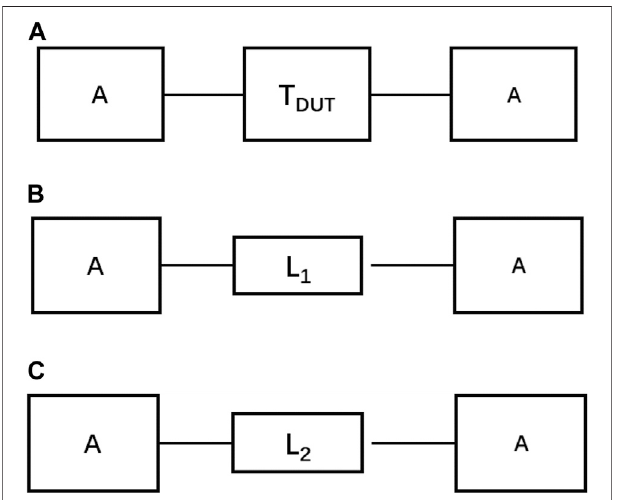
FIGURE 5 | Schematic diagrams of numerical TL de-embedding procedure and the two standards in TRL. (A) Two-port equivalent network under the numerical TL calibration. (B) Through standard. (C) Line standard.